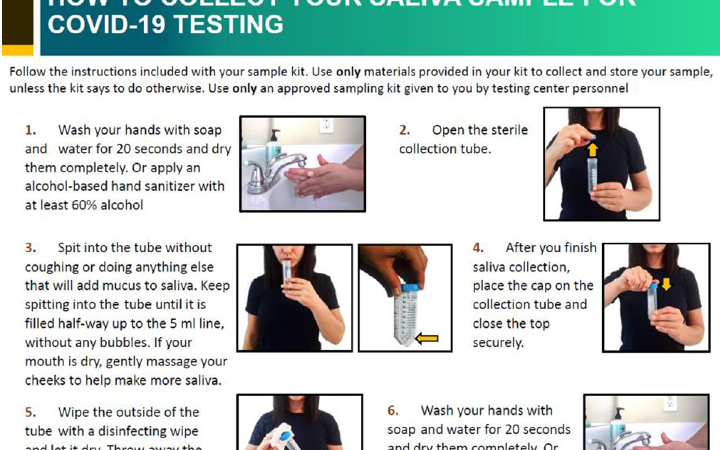
PLOS ONE | https://doi.org/10.1371/journal.pone.0264085 March 9,